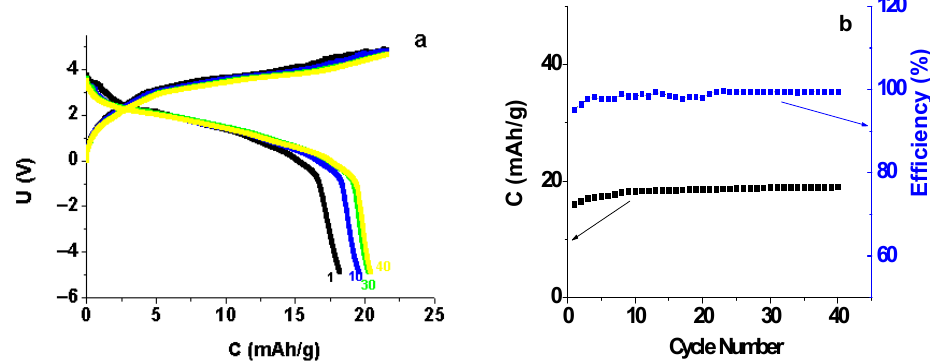
Figure 14. ( a )-Galvanostatic charge/discharge curves ( a ) for Li|Li 3.8 Ge 0.9 S 0.1 O 4 |Li 1.3 V 3 O 8 cell (1st, 10th, 30th and 40th cycles) and Coulombic efficiency curve ( b ). 13 μА /sm 2 , 100 ° С .